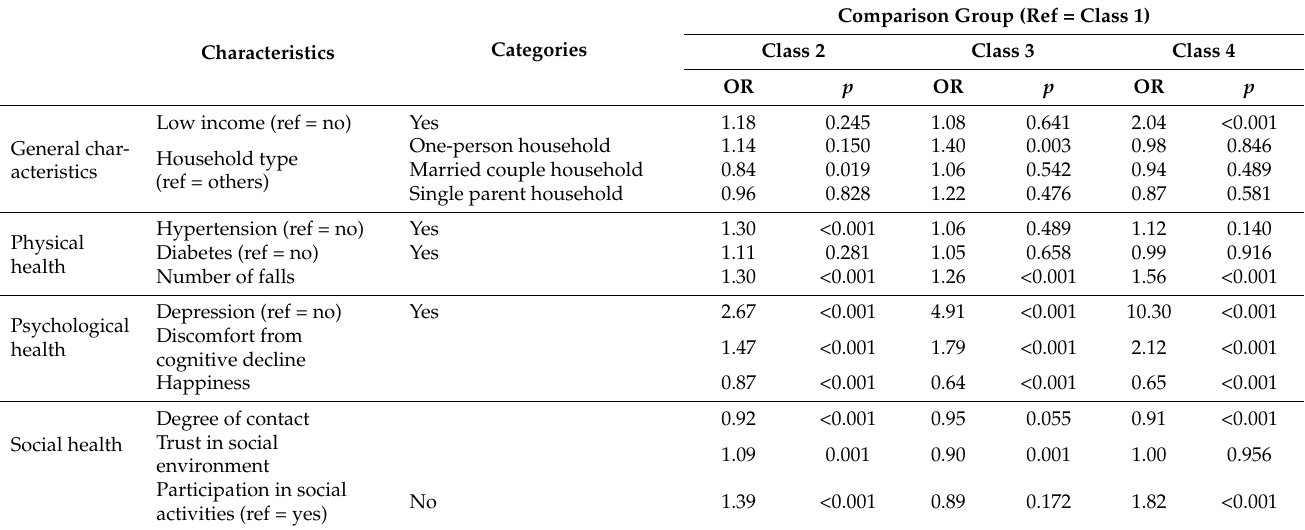
Table 4. Factors influencing latent